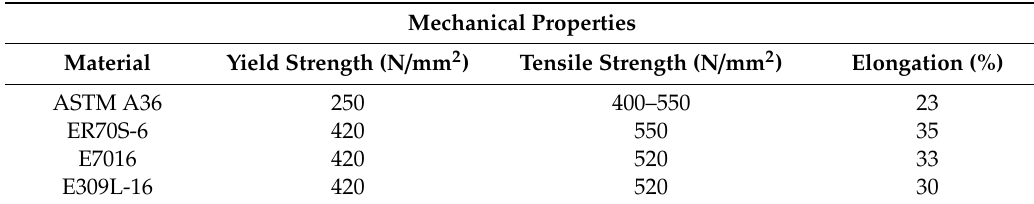
Table 3. Mechanical properties of the considered materials in this study.